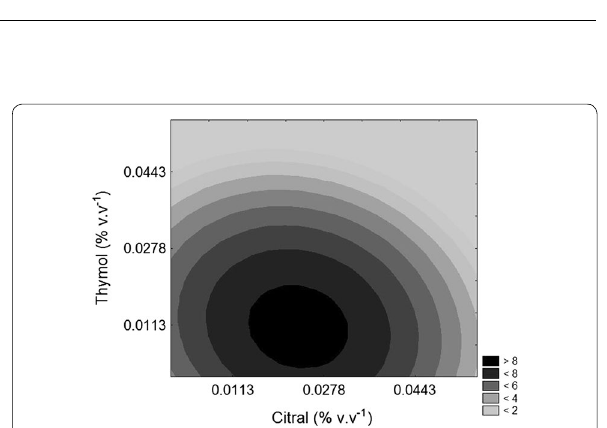
Fig. 3 Contour curve for planktonic cells (PC) count (Log CFU mL − 1 ) as a function of citral and thymol concentration (linalool concentration was fixed at the lowest level—0.0003% v v − 1